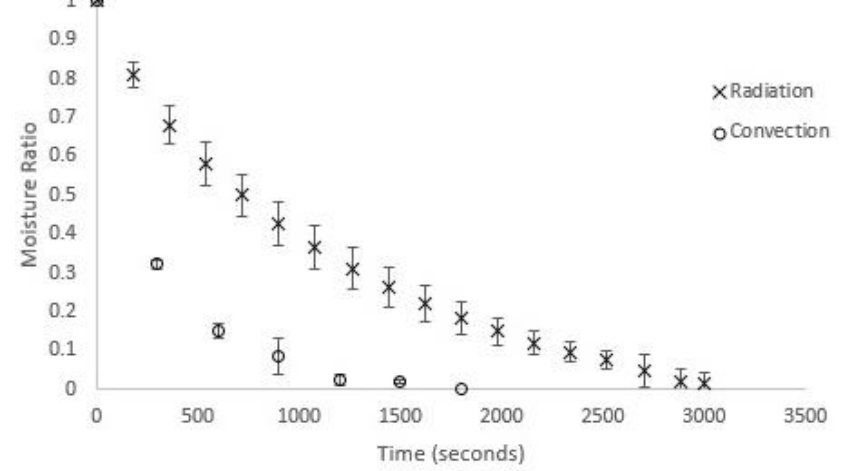
◦ C for radiative and convective